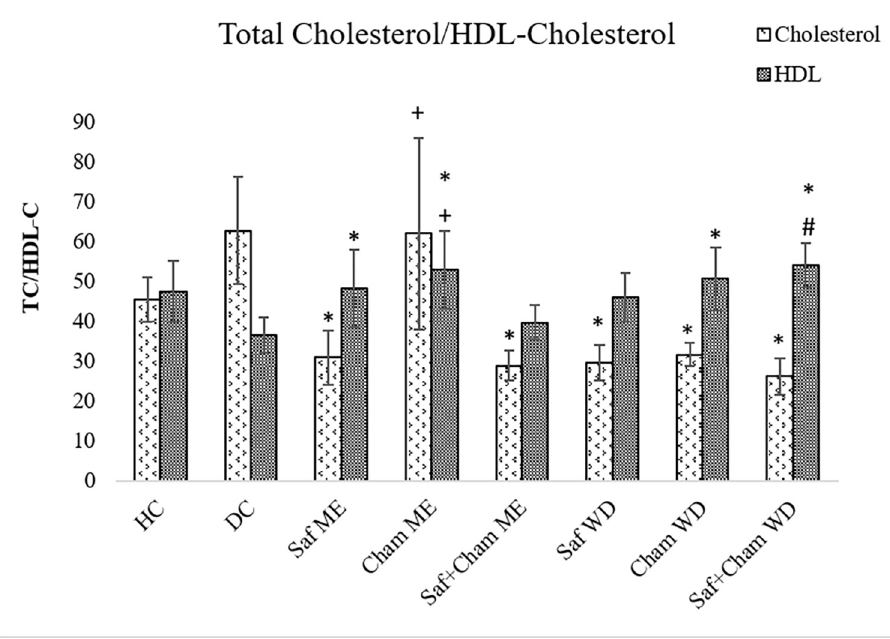
Fig 4. Effects of saffron, chamomile and their co-administration in ME and WD on Total cholesterol/HDL- cholesterol in streptozotocin-induced diabetic rats. Values are presented as means ± SD (n = 10). Tukey’s test Significant values: � p < 0.05 from control DC, + p < 0.05 from Saffron+Chamomile ME group, # p < 0.05 from Saf +Cham WD.